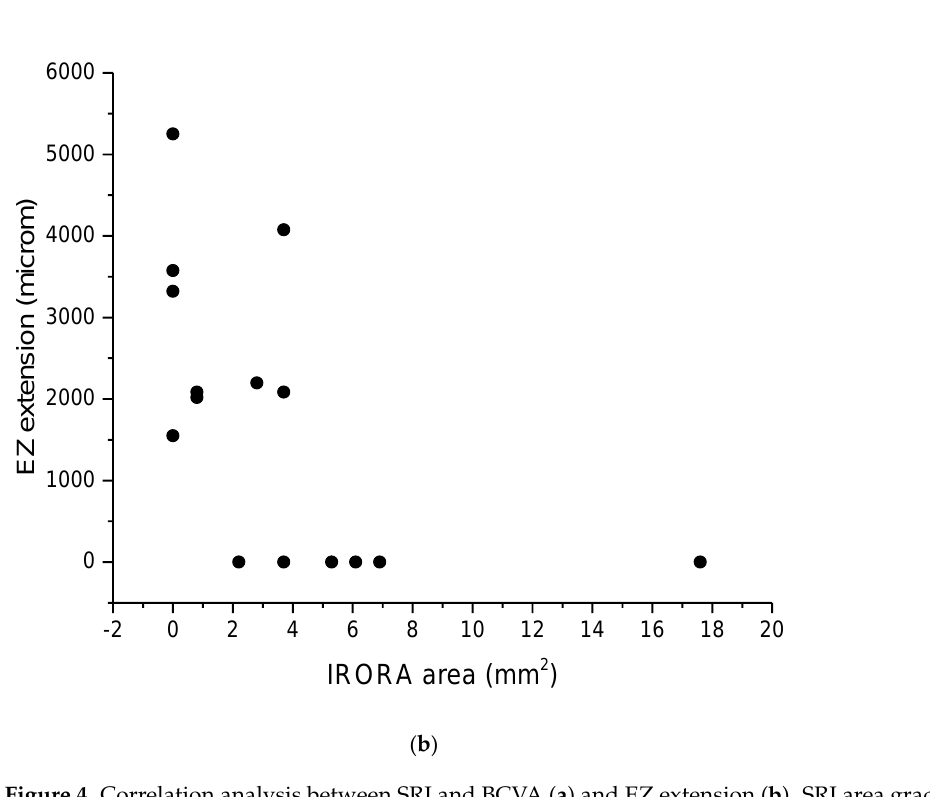
Figure 4. Correlation analysis between SRI and BCVA ( a ) and EZ extension ( b ). SRI area gradually increases as visual acuity and/or ellipsoid zone extension